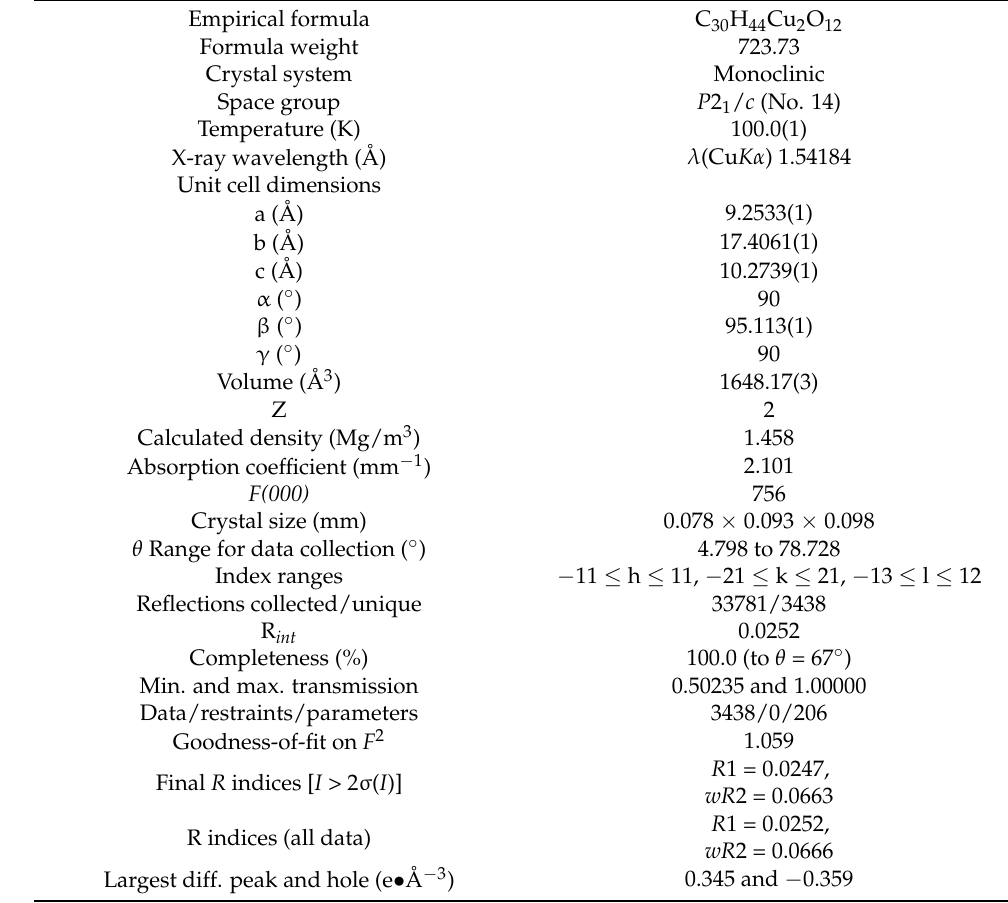
Table 1. Crystal data and structure refinement details for [Cu 2 (tig) 4 (tigH) 2